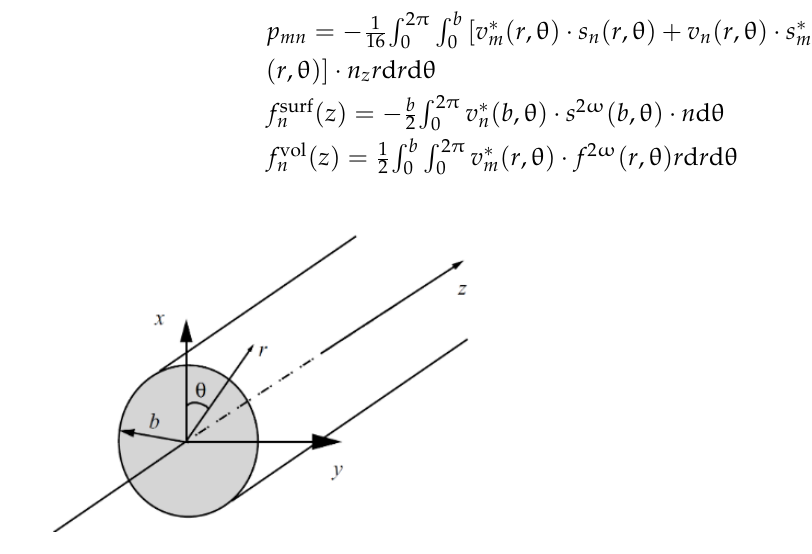
Figure 1. Diagram of cylindrical waveguide rod.